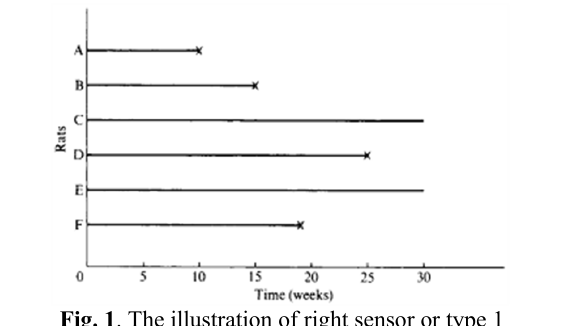
Fig. 1 . The illustration of right sensor or type